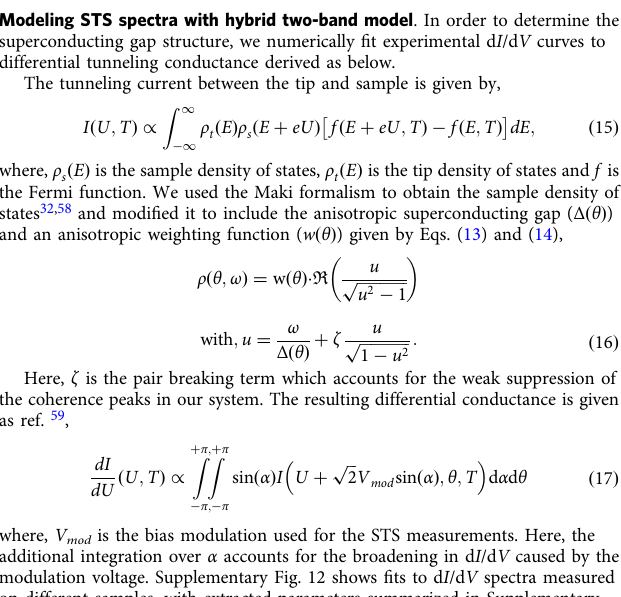
Table 1. The standard error in each parameter is